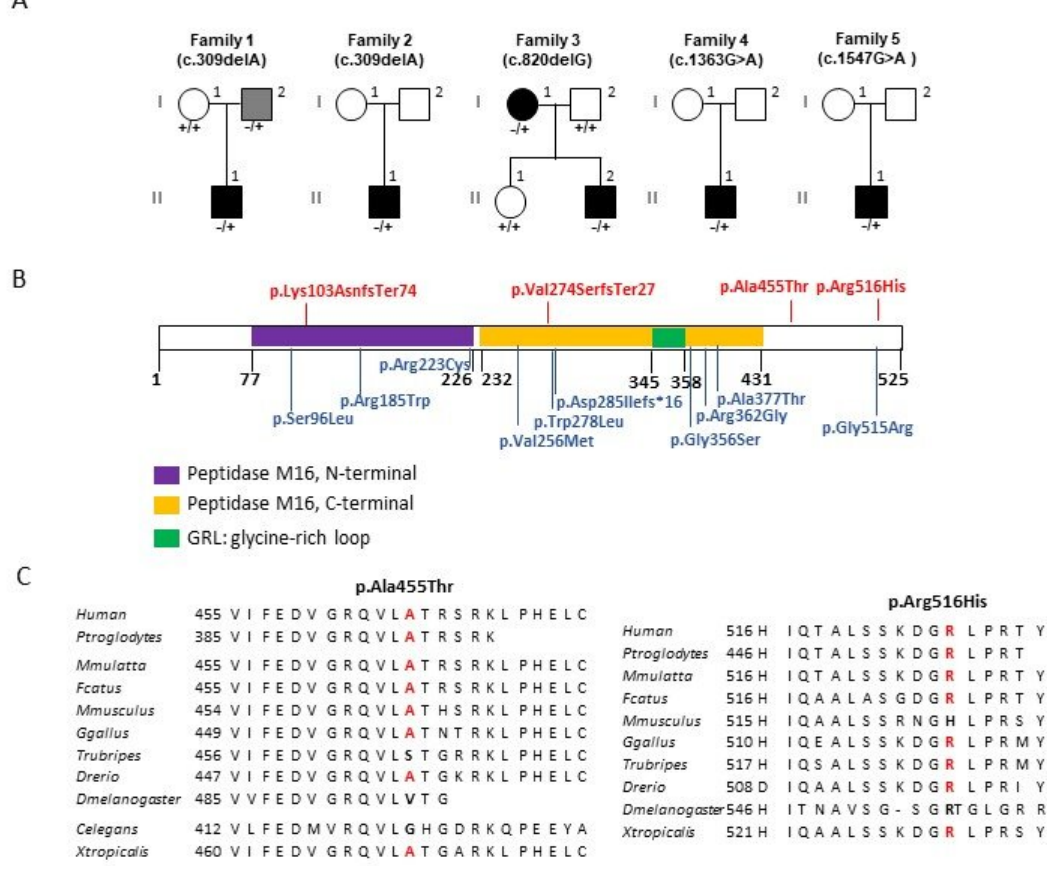
Figure 1. PMPCA pedigrees and amino acid change localization. ( A ): Description of the pedigrees with PMPCA (NM_015160.3) variants and their segregation among the families. ( B ): The structure of the PMPCA protein with the amino acid changes associated with DOA on the top, and associated with Spinocerebellar ataxia, autosomal recessive 2 (SCAR2) and a progressive mitochondrial encephalopa- thy, on the bottom. ( C ): Evolutionary conservation of the p.Ala455 and p.Arg516 residues (in red) and their neighbor amino acids in eukaryotic PMPCA protein sequences of metazoans and invertebrates. Table 1. Clinical and Molecular Data of the PMPCA